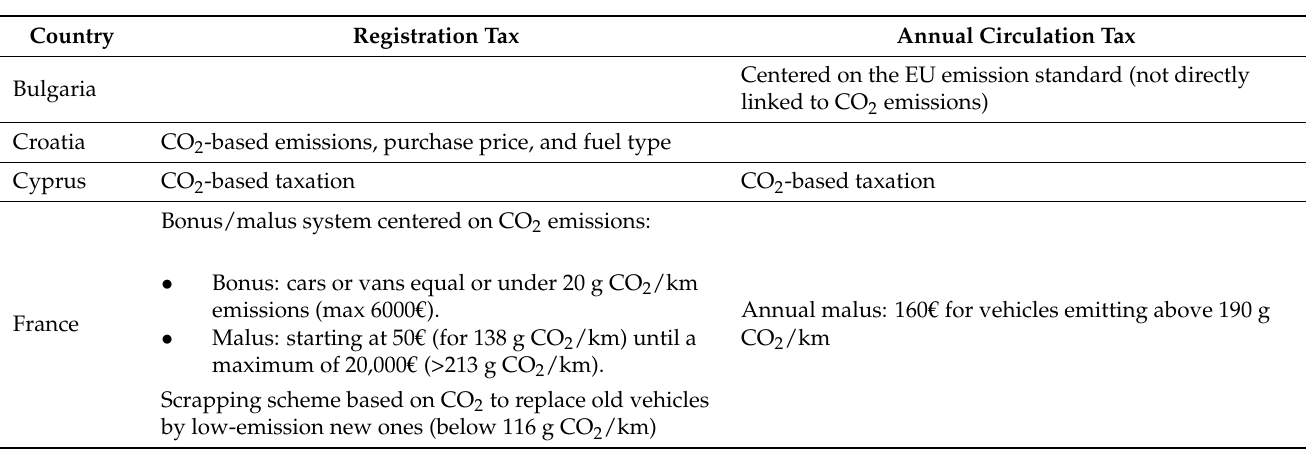
Table 1. Vehicle Taxes in the Mediterranean